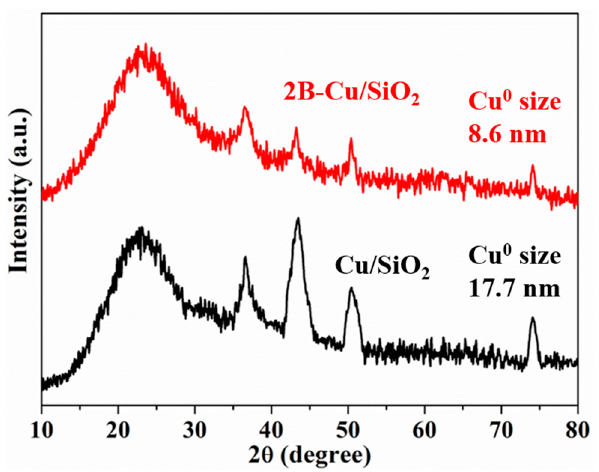
Figure 10. XRD patterns of Cu/SiO 2 and 2B-Cu/SiO 2 catalysts after 150 h long-term catalytic test.